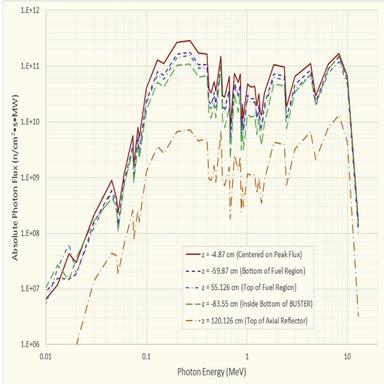
Absolute Photon Flux Axial Spectral Distribution for Full-Slotted Core (300 K).